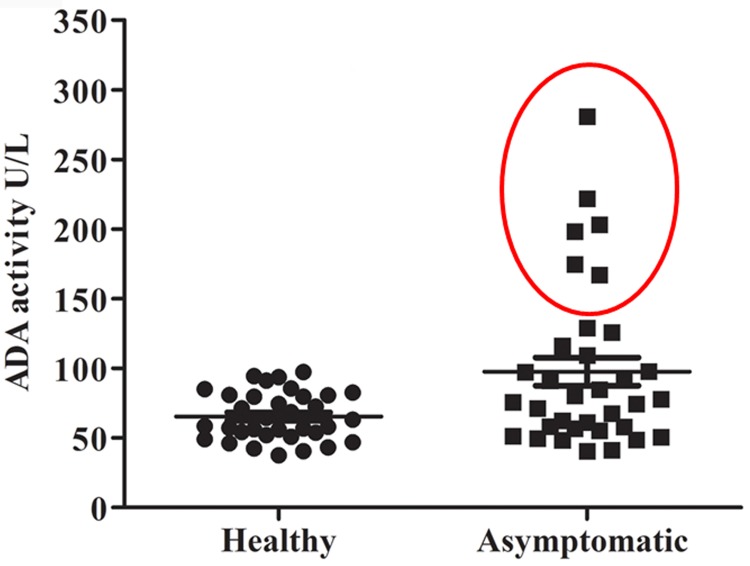
Serum ADA activity of endemic healthy subjects (n = 34) and endemic asymptomatic (n = 34) subjects.17.6% (6 out of 34) asymptomatic subjects possessed higher ADA activity (marked with red circle).